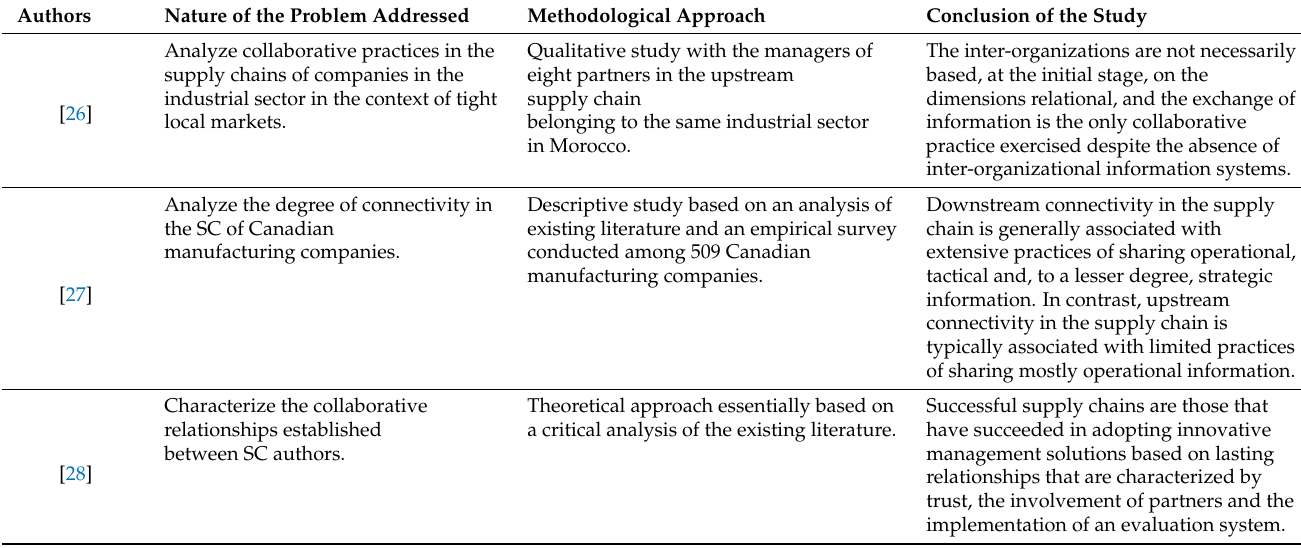
Table 3. Illustration of some methodological approaches adopted by previous studies on SC and